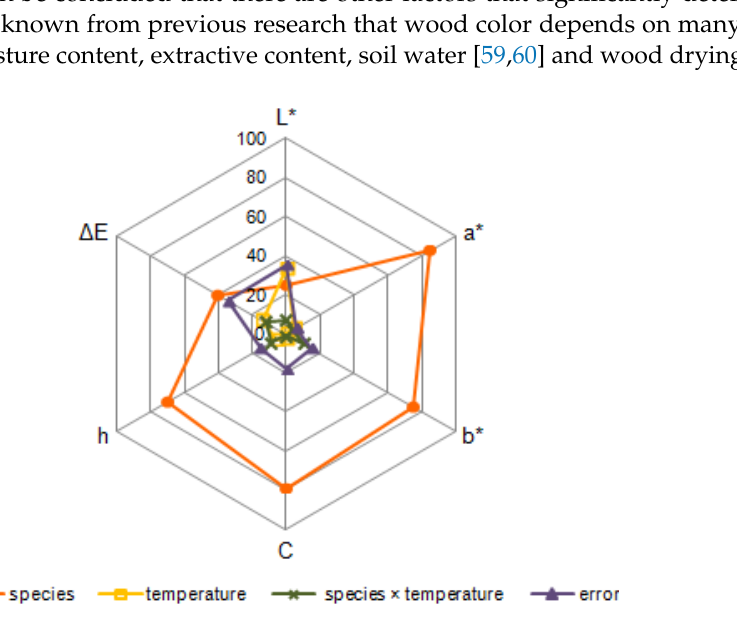
Figure 2. Factors influencing the color parameters and total color change ( ∆ E) of thermo-mechanically modified iroko and tauari wood (Fischer’s F -test; p ≤ 0.05).